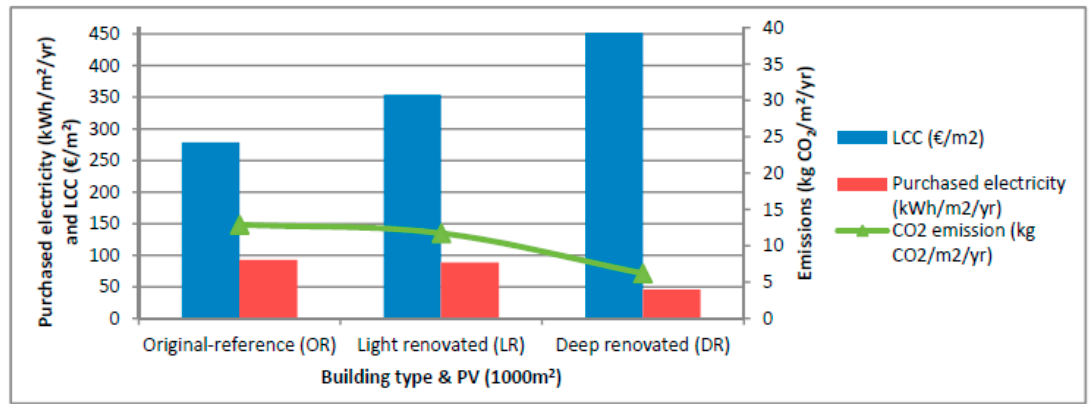
Figure 11. The annual purchased electricity, LCC, and CO 2 emissions from the centralized community-level PV and A2WHP-based energy system integrated with old residential buildings (Case 2, PV + A2WHP).